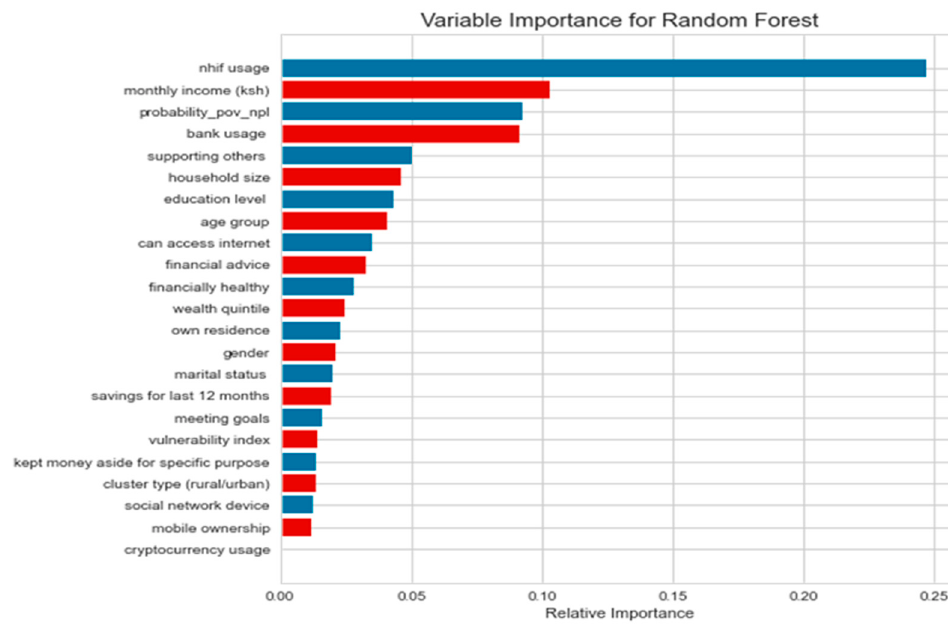
Figure 6. Feature importance from random forest.